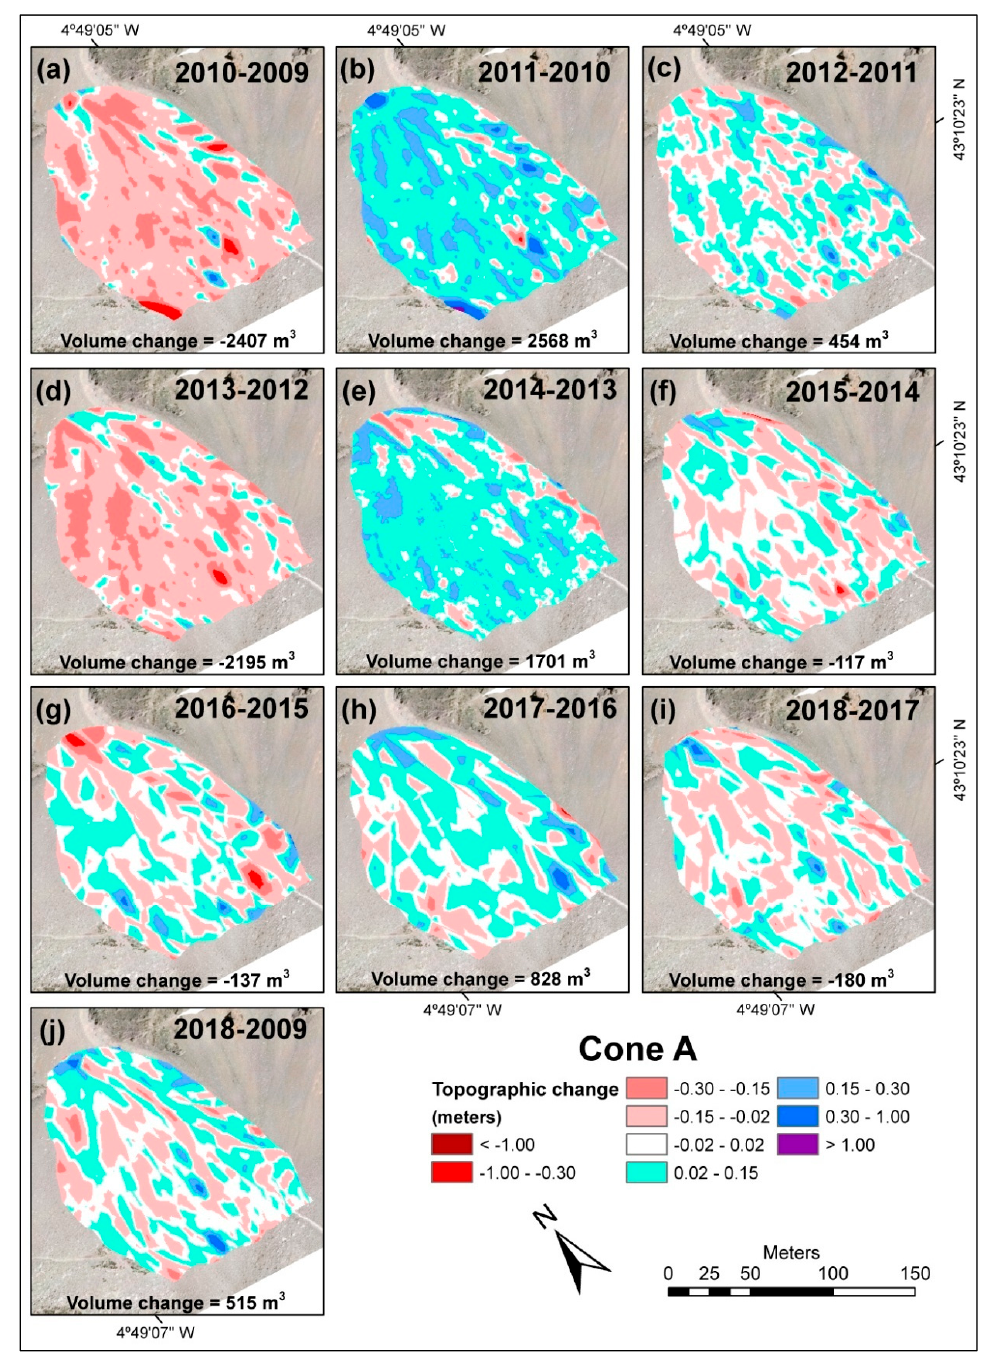
Figure 13. Annual (a–i) and total (j) differences (2018–2009) in volumes in Cone A. Figure 13. Annual ( a – i ) and total ( j ) di ff erences (2018–2009) in volumes in Cone The total of the period analyzed showed an insignificant increase in rock material of 515 m3.